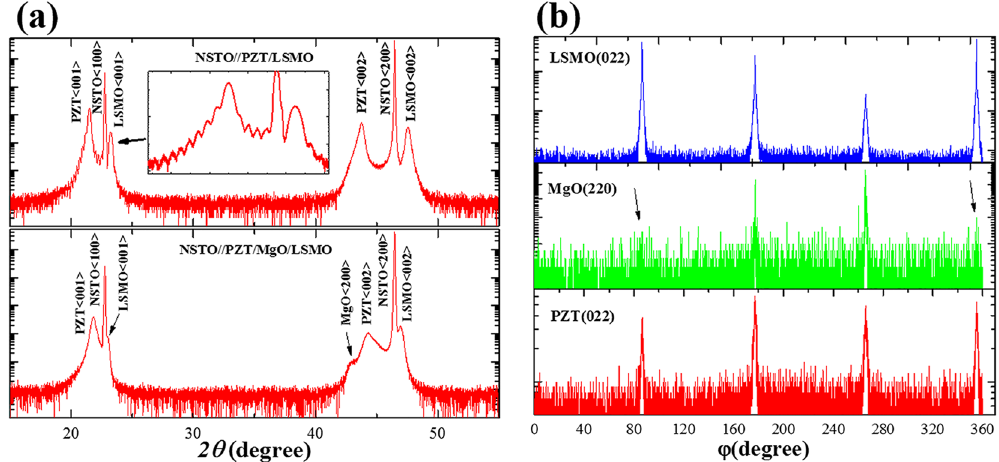
Figure 1. ( a ) XRD θ -2 θ scans of the NPL and NPML heterostructures respectively. ( b ) Phi-scan for the LSMO, MgO, and PZT layers of the NPML,